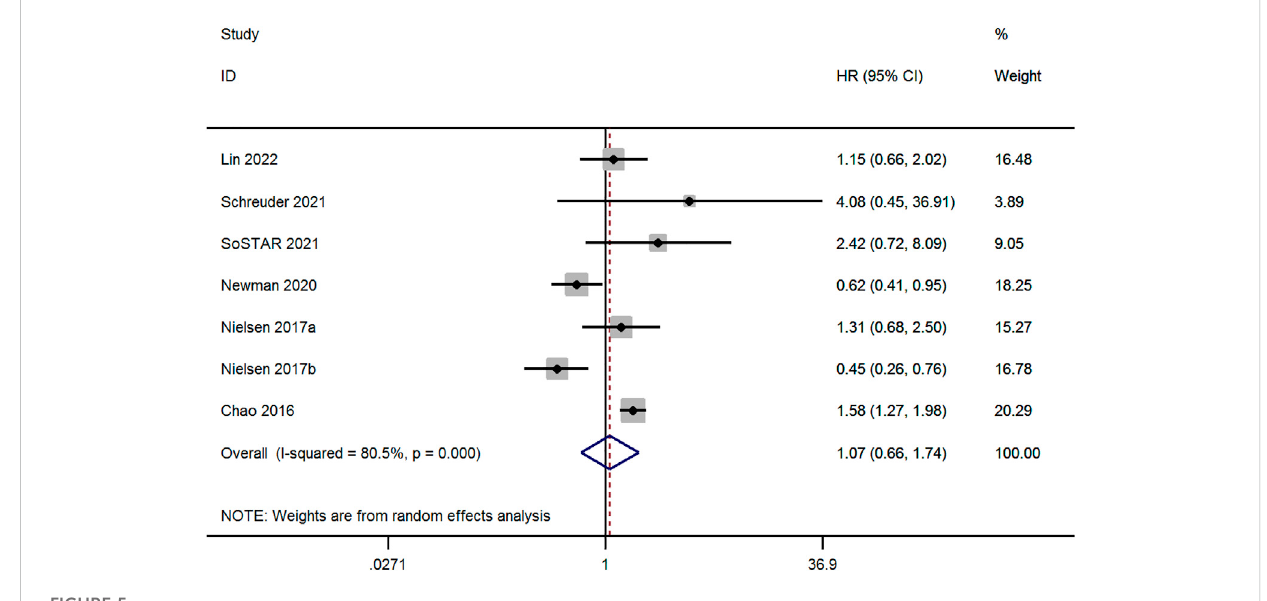
FIGURE 5 Meta-analysis of the risk of recurrent ICH in OAC versus non-OAC.